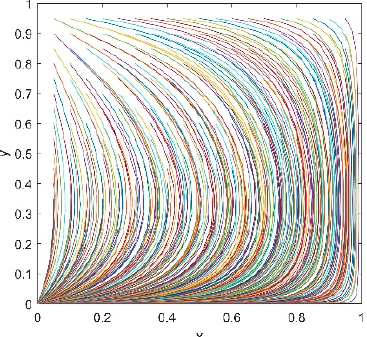
Figure 7. Strategies’ evolutions of the grid company and user over time in Case 2.